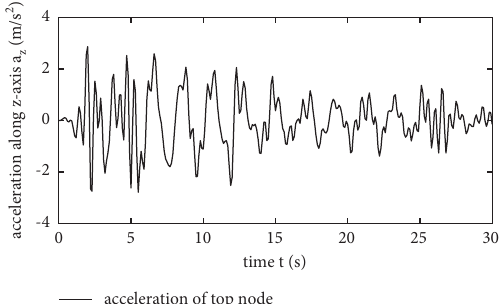
Figure 11: Acceleration of top node (o) along the (z)-axis.